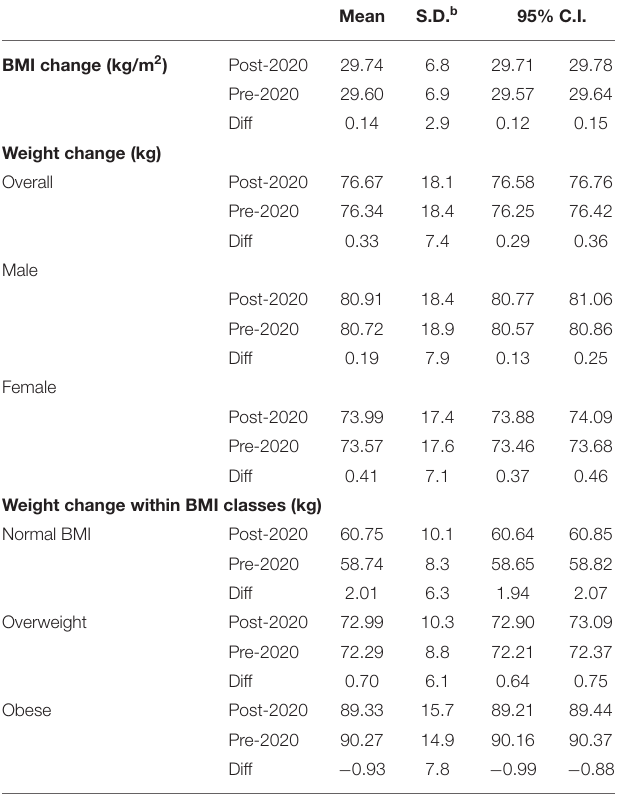
TABLE 2 | Change in BMI and weight pre- and post-2020 a